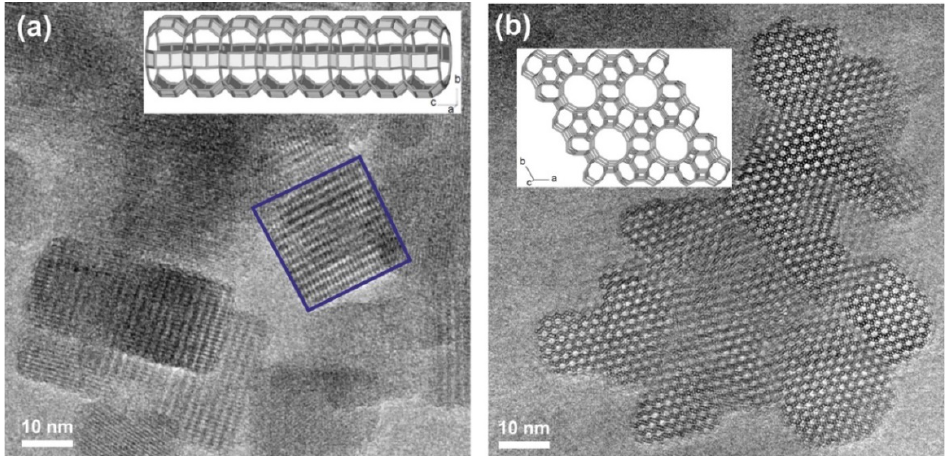
Figure 1. High-Resolution Transmission Electron Microscopy (HRTEM) images of LTL nanocrystals projected along the directions [100] in ( a ) and [001] in ( b ) (SG P6/mmm).